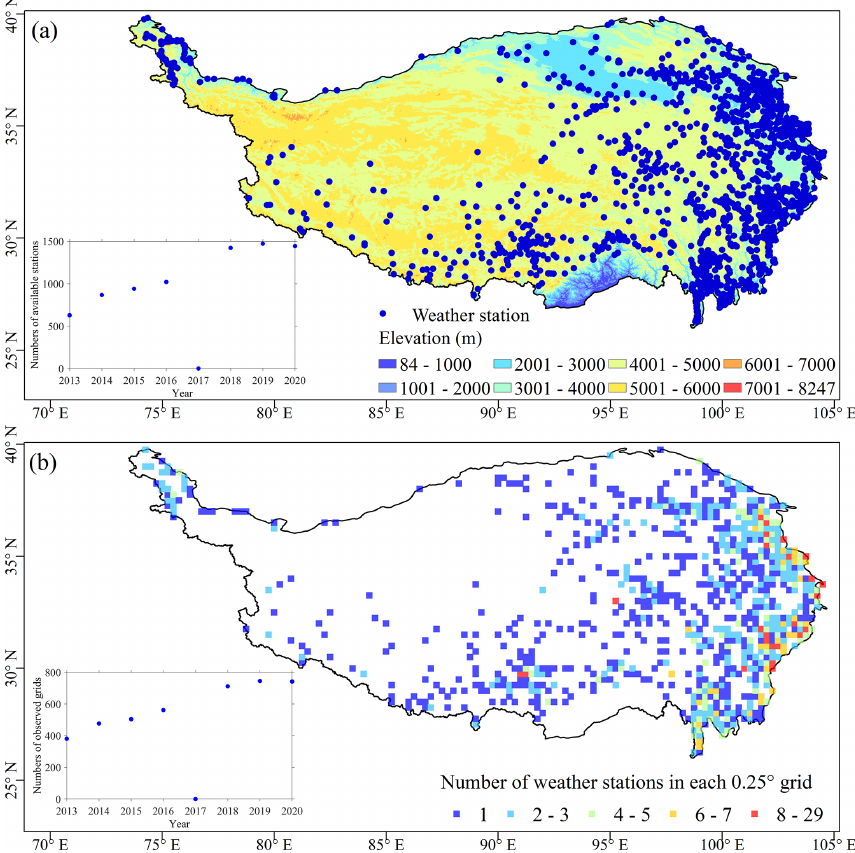
Figure 1. (a) Spatial distribution of weather stations on TP; the inset shows the number of available weather stations by year. (b) Number of available weather stations in each grid with 0.25 ◦ spatial resolution; the inset shows the number of available weather stations by